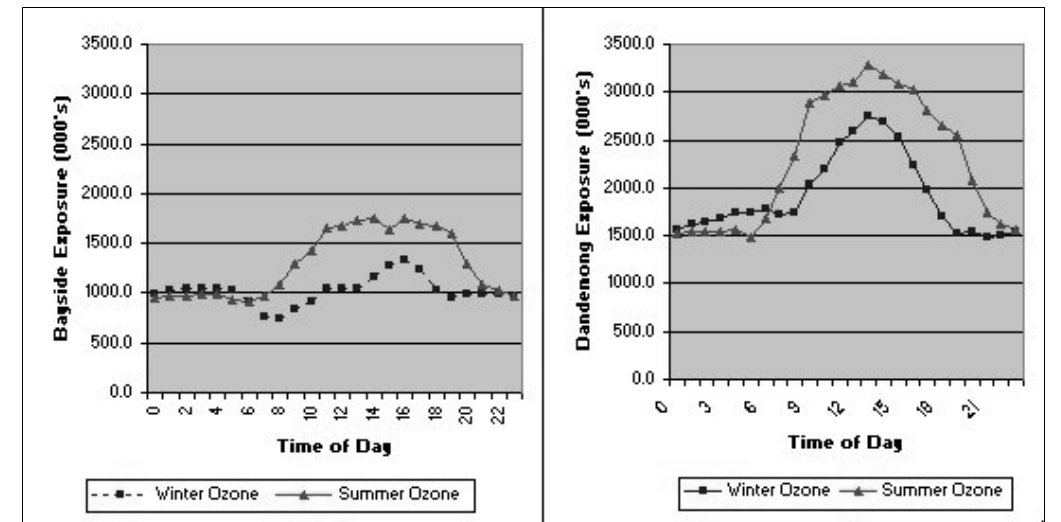
Figure 9. Seasonal ozone exposure for Bayside and